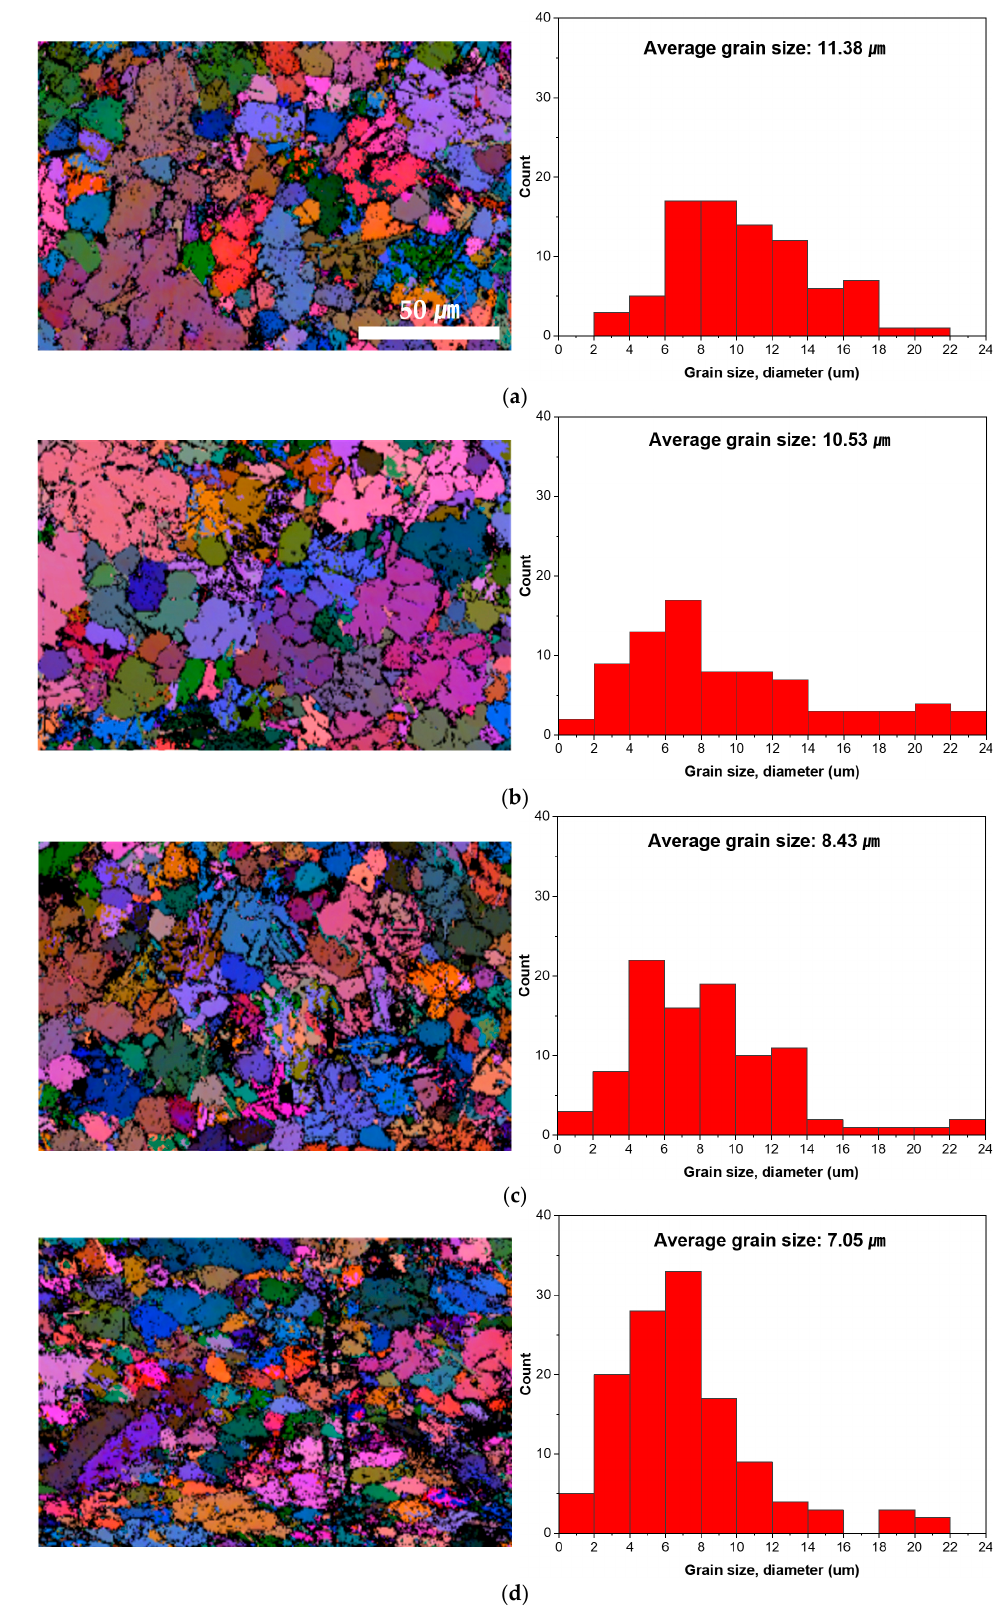
Figure 6. EBSD analysis results of ( a ) A383 alloy cast using a single gate and ( b ) poly gate and ( c ) 1.0 wt% CNT-added composite cast using a single gate and ( d ) poly